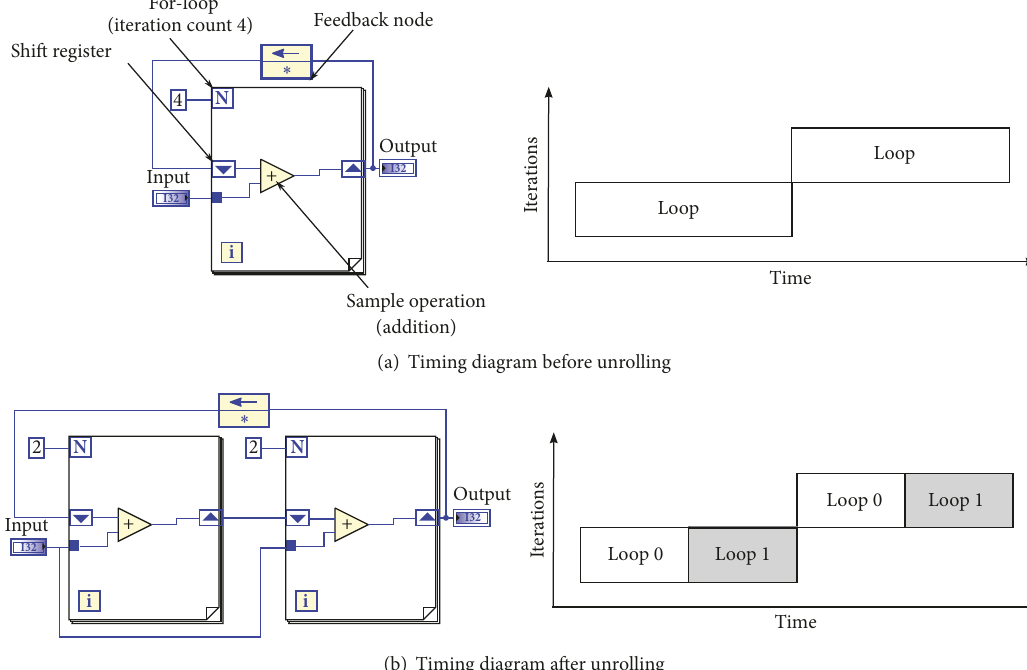
Figure 4: Ineffective loop unrolling. Shown on the left are representative schematics of the LabVIEW graphical programming virtual instruments (VI), and on the right are the corresponding timing diagrams.